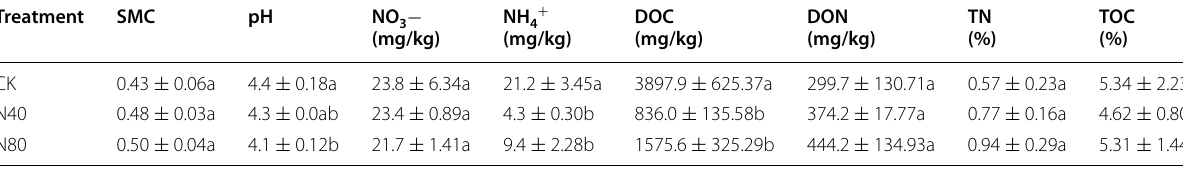
Each treatment was performed in triplicate. The data are expressed as the mean